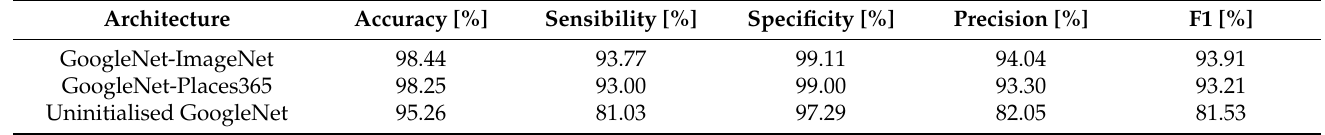
Table 5. GoogleNet training results after augmentation.